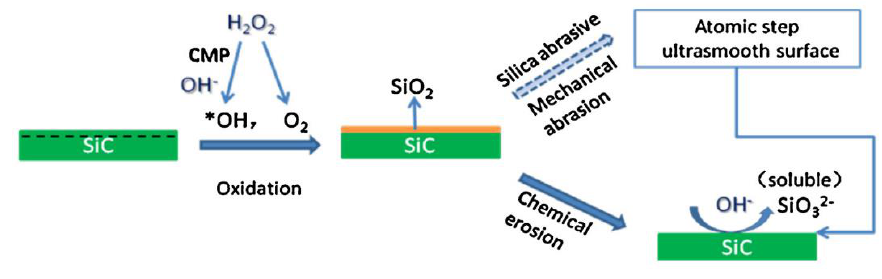
Figure 9. Probable mechanism of scratch removal in MAS CMP [29].